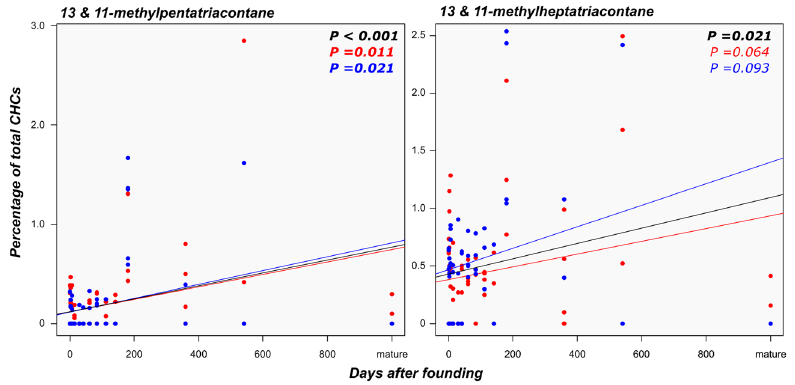
Figure 4. Relationship between the time elapsed since the foundation of incipient colonies and the production of 13/11-methylpentatriacontane and 11/13-methylheptatriacontane in founding primary